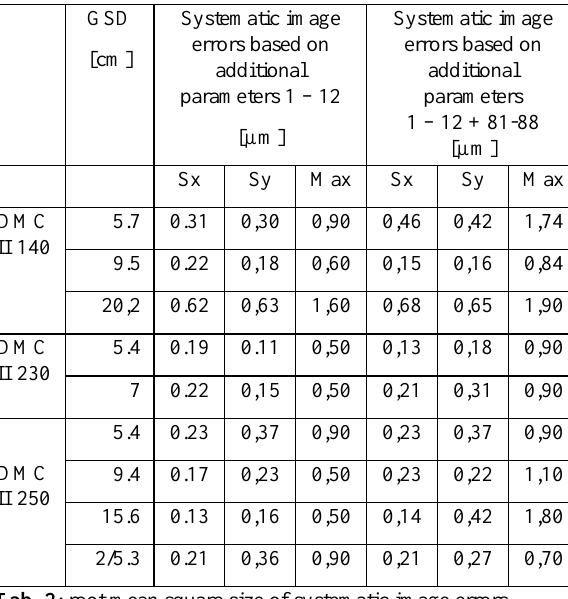
Tab. 2 : root mean square size of systematic image errors The root mean square values of the systematic image errors are a little larger for the DMCII 140. As visible in figure 4 there are small radial symmetric components. Especially the data set with 20.2cm GSD shows with radial symmetric components up to 1.3µm in the image corners. Without the radial symmetric components the root mean square value of the systematic image errors is just in the range of approximately